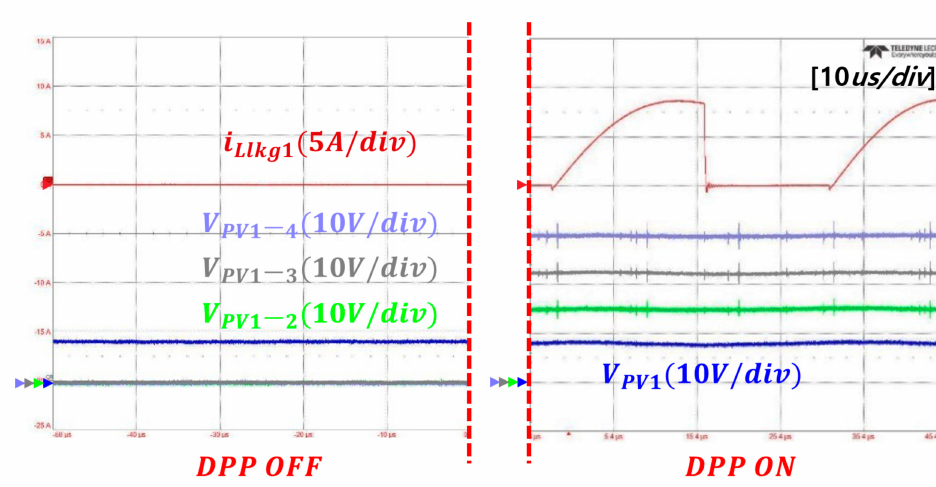
Figure 14. Experimental key waveform of submodule voltage with respect to the DPP operation.